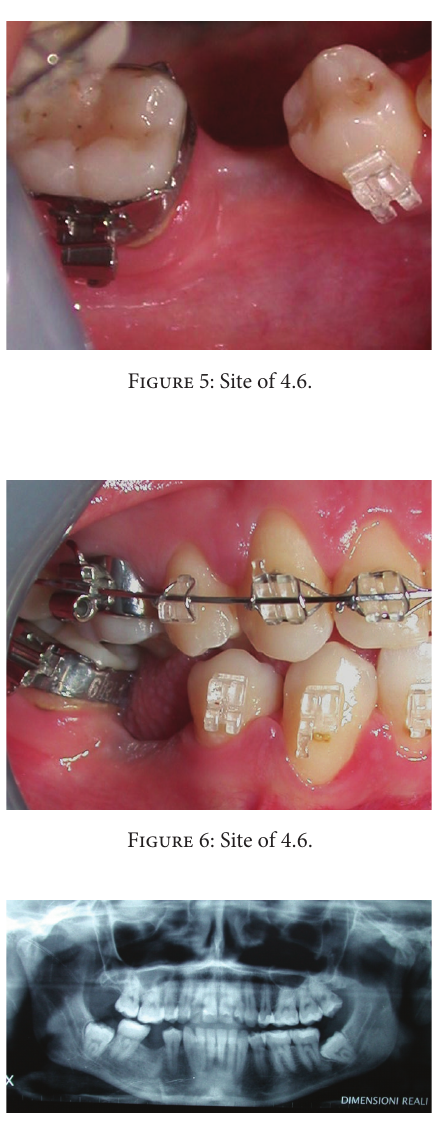
Figure 7: Panoramic view (OPT).